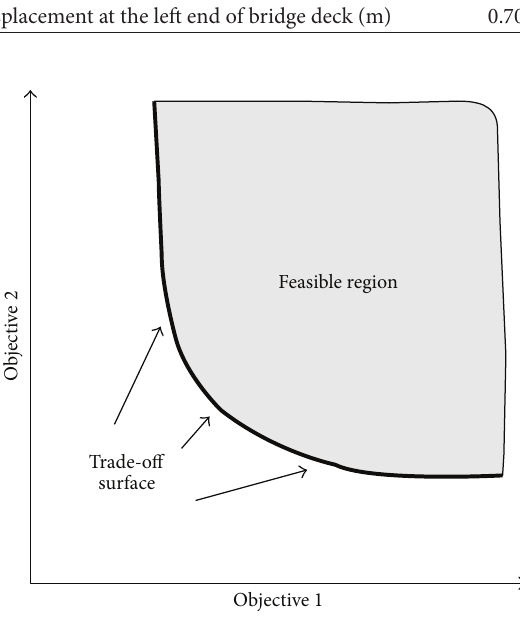
Figure 13: Trade-off between two competing objectives [17].